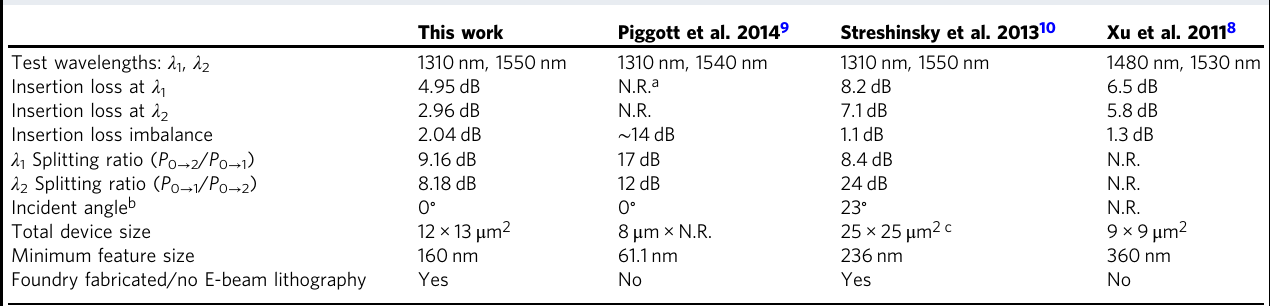
a N.R.: data not reported in the corresponding publication. b With respect to the normal angle. c Approximated from fi